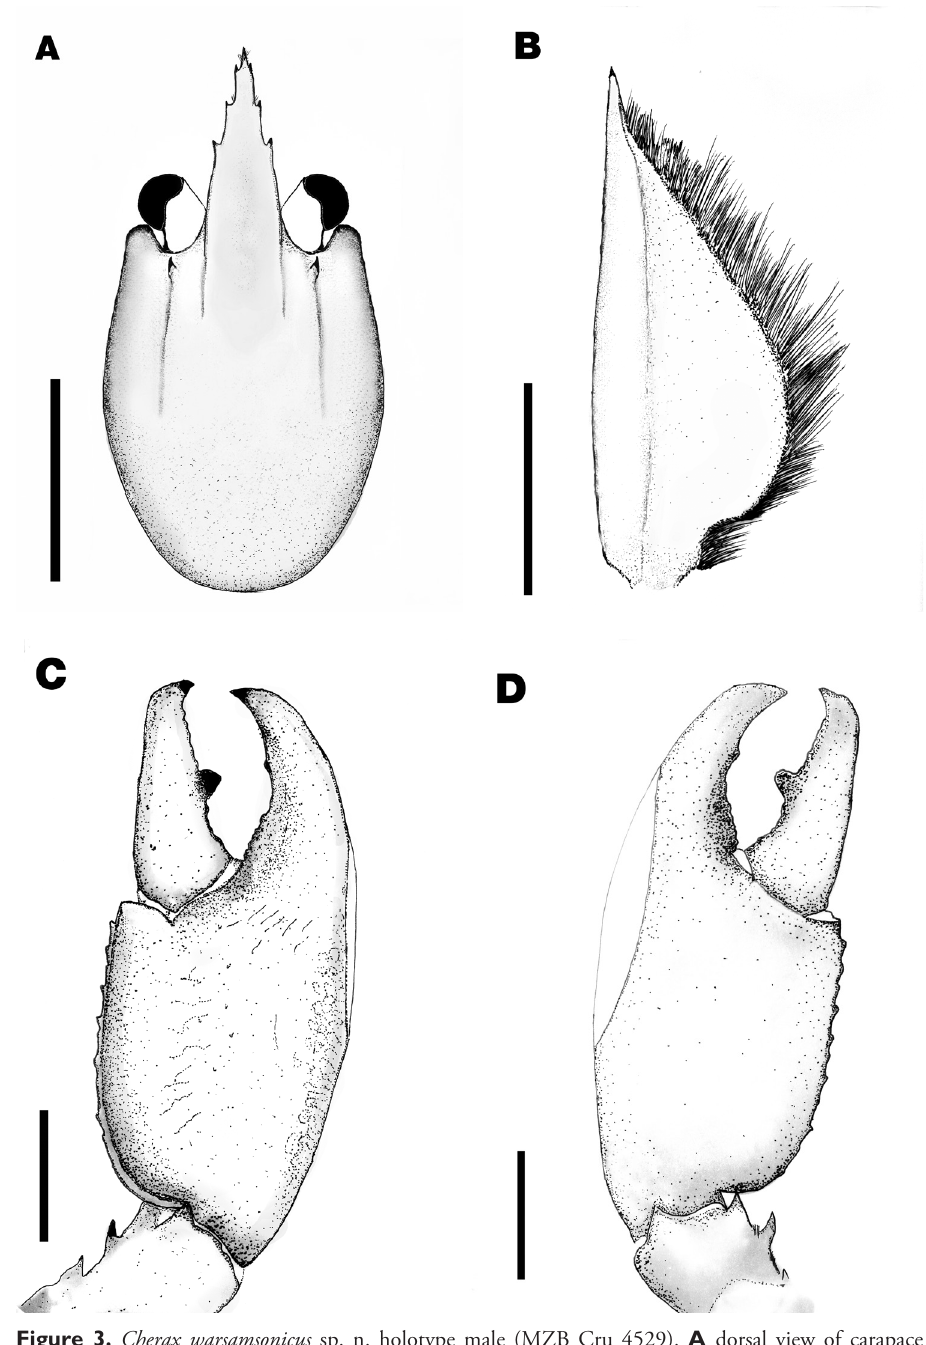
Figure 3. Cherax warsamsonicus sp. n. holotype male (MZB Cru 4529). A dorsal view of carapace B scaphocerite C dorsal view of right chelae D ventral view of left chelae. Scale bars: A, C, D 10 mm, B